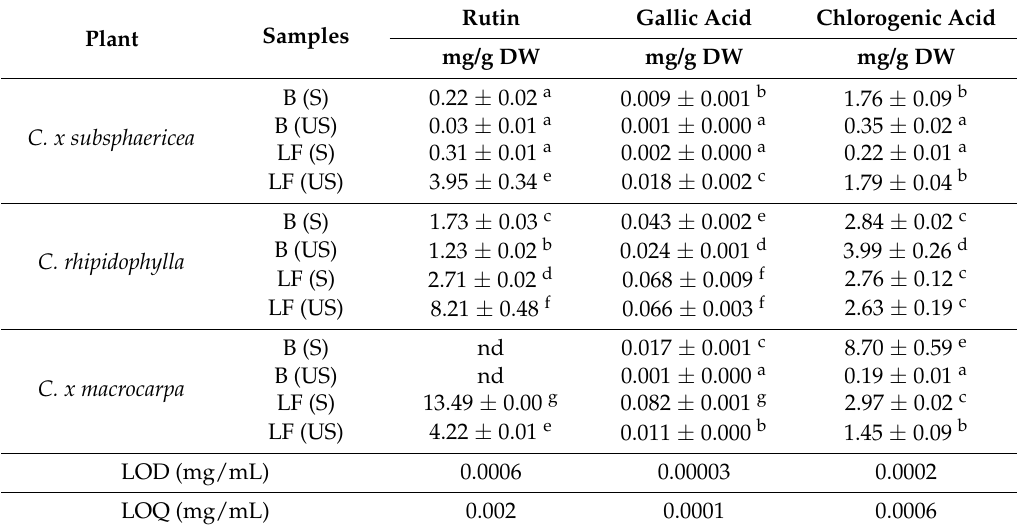
Table 2. The content of rutin and gallic and chlorogenic acid in the Crataegus samples. Plant Samples